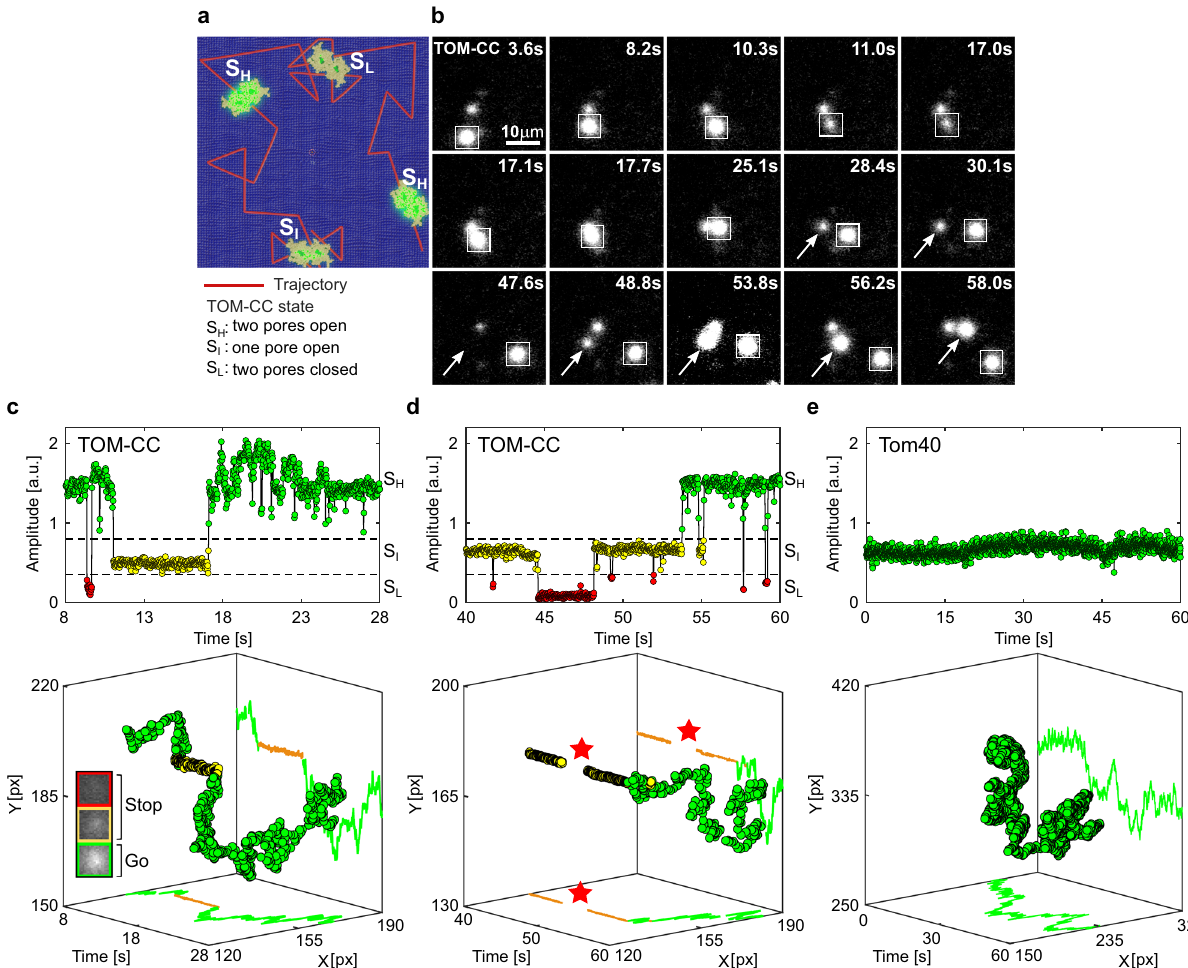
Fig. 3 Lateral mobility correlates with the channel activity of TOM-CC. a Scheme for imaging both position and channel activity of single TOM-CCs. b Representative TIRF microscopy images of a non-modi fi ed agarose-supported DIB membrane with three TOM-CC molecules taken from a time series of 60 s. The square-marked spot displays lateral motion, interrupted by a transient arrest between t = 11.0 s and t = 17.0 s. The arrow-marked spot corresponds to a non-moving TOM-CC until t = 48.8 s. Afterwards, it starts moving. Both moving spots show high fl uorescence intensity (S H ); the non- moving spots display intermediate (S I ) or dark (S L ) fl uorescence intensity (Supplementary Movie S3). c , d Fluorescent amplitude trace and corresponding trajectory of the square- and arrow-marked TOM-CC as shown in ( b ) highlighted for two different time windows. Plots on top shows the change of amplitude over time, and plots on the bottom show the respective spatiotemporal dynamics for the three states. Comparison of the trajectories of single TOM-CC molecules with their corresponding amplitude traces reveals a direct correlation between stop-and-go movement and open-closed channel activity. Lateral diffusion of TOM-CCs in the DIB membrane is interrupted by temporary arrest, presumably due to transient linkage to the underlying agarose hydrogel. Although weak intensity pro fi les in S I do not allow accurate position determination, the fl uorescent spots disappear and reappear at the same spatial x, y coordinates (red stars). The higher amplitude ( c top) between t = 17.1 s and t = 25.1 s is due to the overlap between two adjacent spots. Green, TOM-CC is freely diffusive in S H ; yellow and red, immobile TOM-CC in S I and S L . e Fluorescent amplitude trace and corresponding trajectory of a single β -barrel subunit Tom40. The Tom40 channel exhibits only one permeability state and is subject to simple thermal movement in the membrane (Supplementary Movie S5). Tom40 does not show stop-and-go motion as with TOM-CC. All data were acquired as described in Fig. 1c at a frame rate of 47.5 s − 1 . A total of n TOM = 64 and n Tom40 = 20 amplitude traces and trajectories were analyzed. a.u., arbitrary